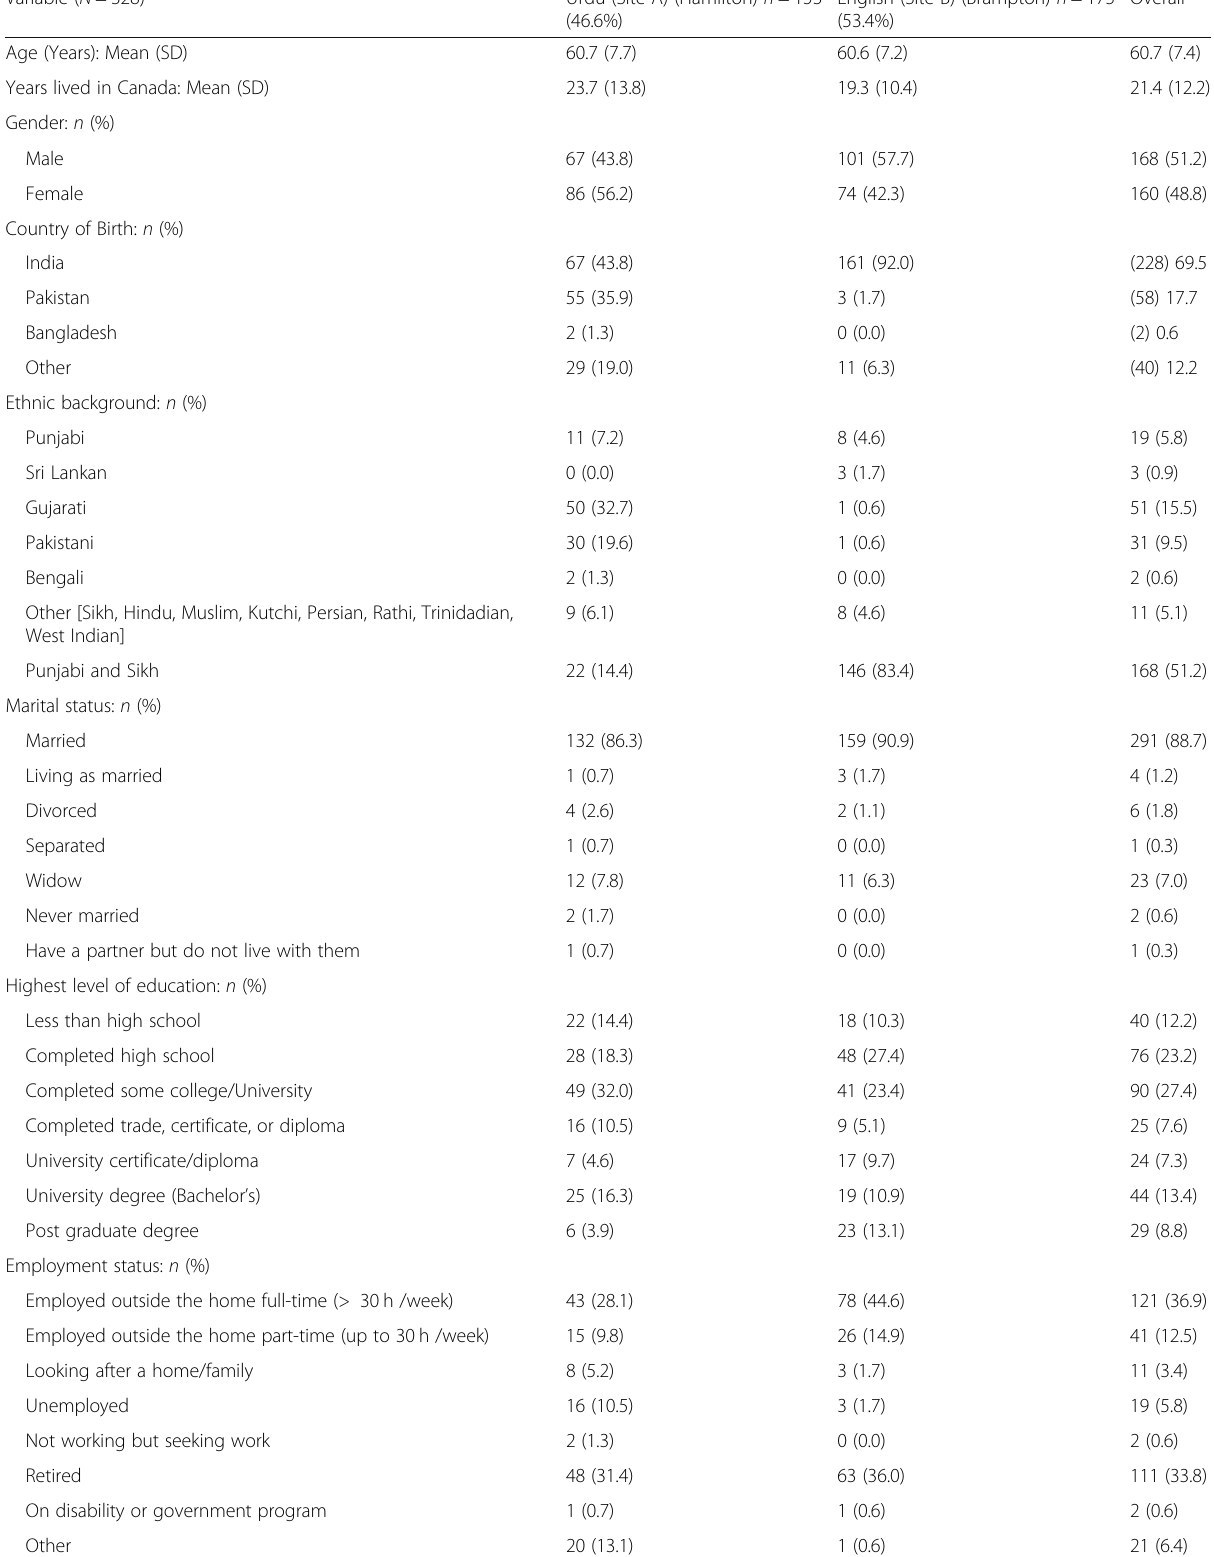
Table 2 Socio-demographic